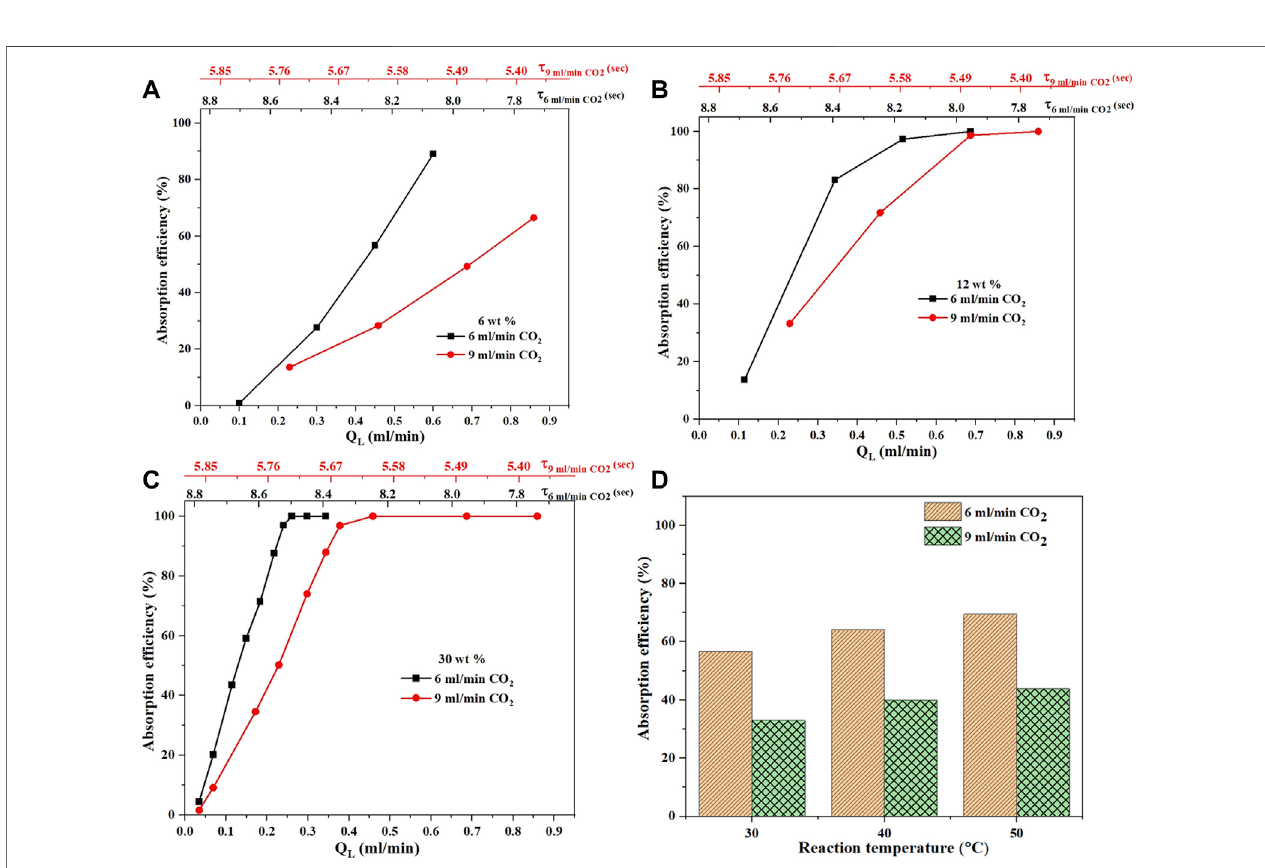
Frontiers in Chemical Engineering |